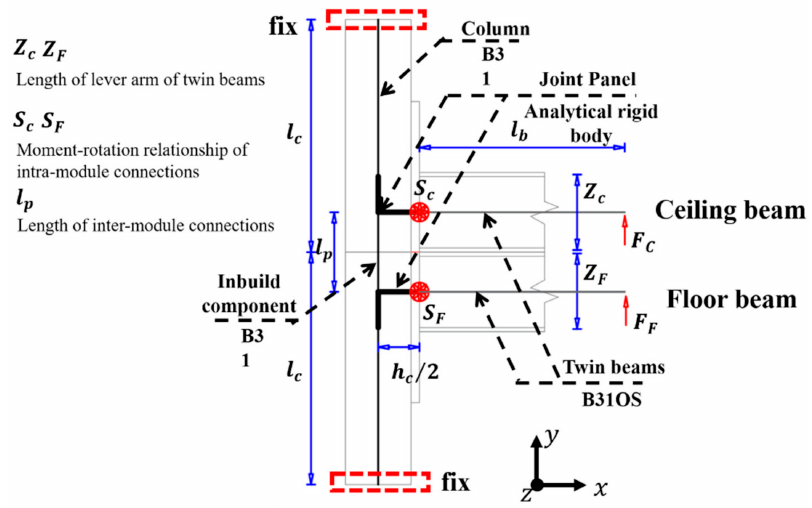
Figure 43. Simplified finite element model of global novel modular connections.